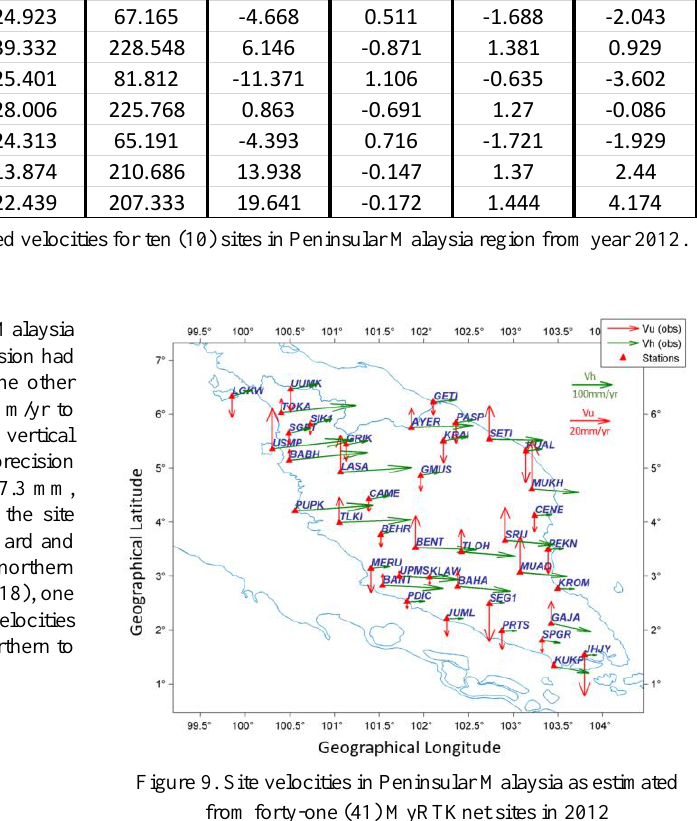
For the validation on the site velocities, the observed velocities were compared with the computed velocities as in Table 1. Ten (10) MyRTKnet sites in Peninsular Malaysia from 2012